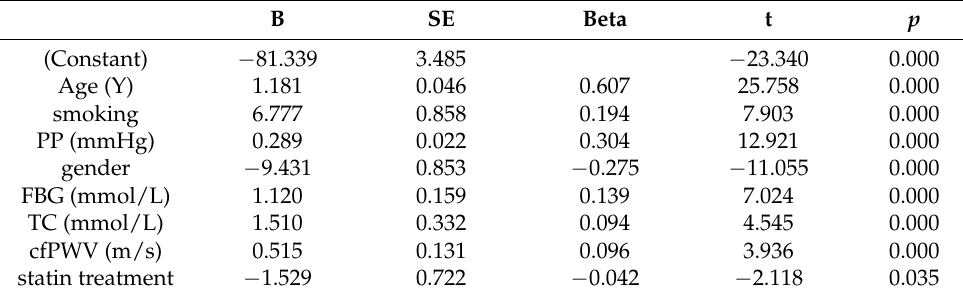
Table 5. Linear regression analysis of associations between ASCVD and cfPWV adjusting for PP and aortic